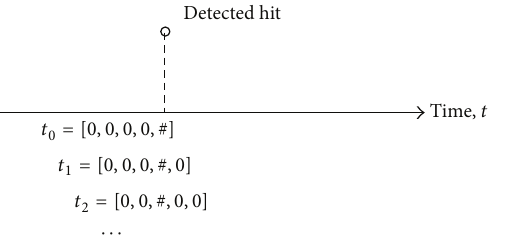
Figure 10: Example of the sliding time window used for